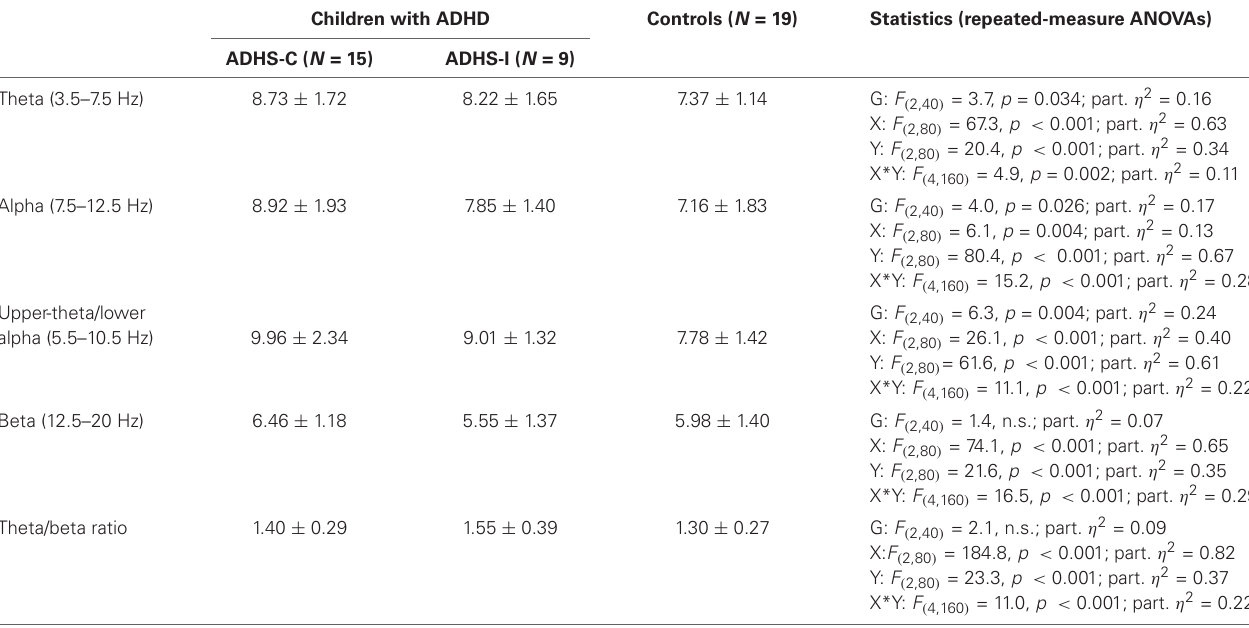
Table 2 | EEG measures and statistical results